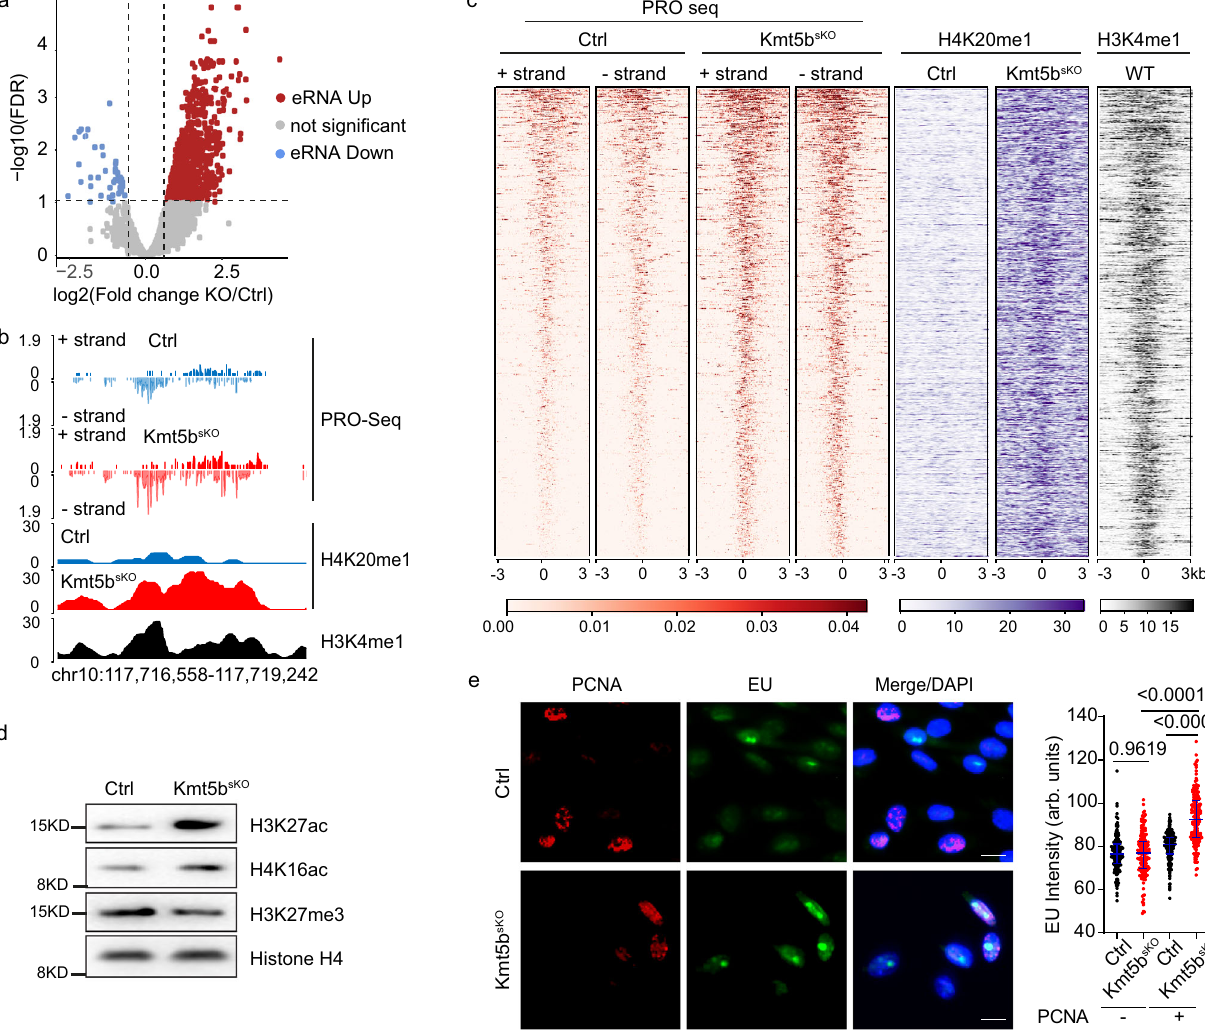
Fig.3|IncreasedaccumulationofH4K20me1promotestranscriptionofalarge group of coding genes and eRNAs. a Volcano plot showing global changes of eRNA transcription in Kmt5b sKO versus Ctrl MuSC. The log2-fold change of mutant/ Ctrl is represented on the x -axis. The y -axis shows the log10 of the false discovery rate (FDR). Dashed grey lines indicate signi fi cant cutoffs (FDR<0.1 and log2 fold- changes >1.5). b Genome browser tracks of PRO-seq and H4K20me1 CUT&RUN signals across a representative enhancer region in Ctrl and Kmt5b sKO MuSCs. H3K4me1ChIP-seq (BioProject: PRJNA412267) identi fi es enhancer regions.Positive and negative values on the y -axis represent normalized library reads mapping to plus and minus strands, respectively. c Heatmaps representing the intensities of PRO-seqsignalsatenhancersidenti fi edbytheNRSAv2pipelineandcorresponding H4K20me1 CUT&RUN signals in Ctrl and Kmt5b sKO MuSC. H3K4me1 ChIP-seq